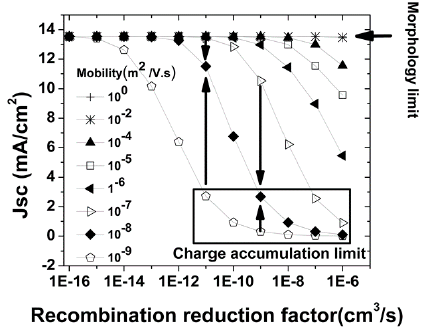
Figure 3. J sc vs. mobility variation for different induced recombination factors.